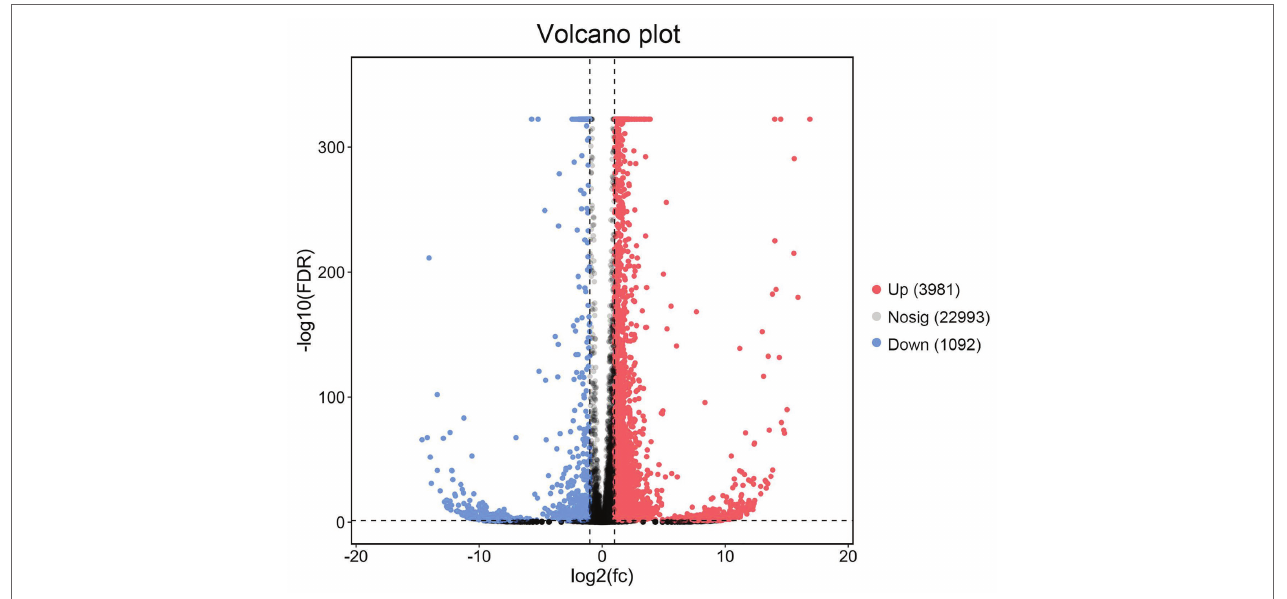
FIGURE 4 | Volcano diagram of differentially expressed genes (DEGs) between TWS119 fed P. vannamei and the control. The X -axis indicates the fold change and the Y -axis indicates the statistical significance of the differences. Red dots represent the significantly upregulated DEGs while blue dots represent the significantly downregulated DEGs (FDR ≤ 0.01 and FC ≥ 2). Gray dots represent the DEGs which are not significantly